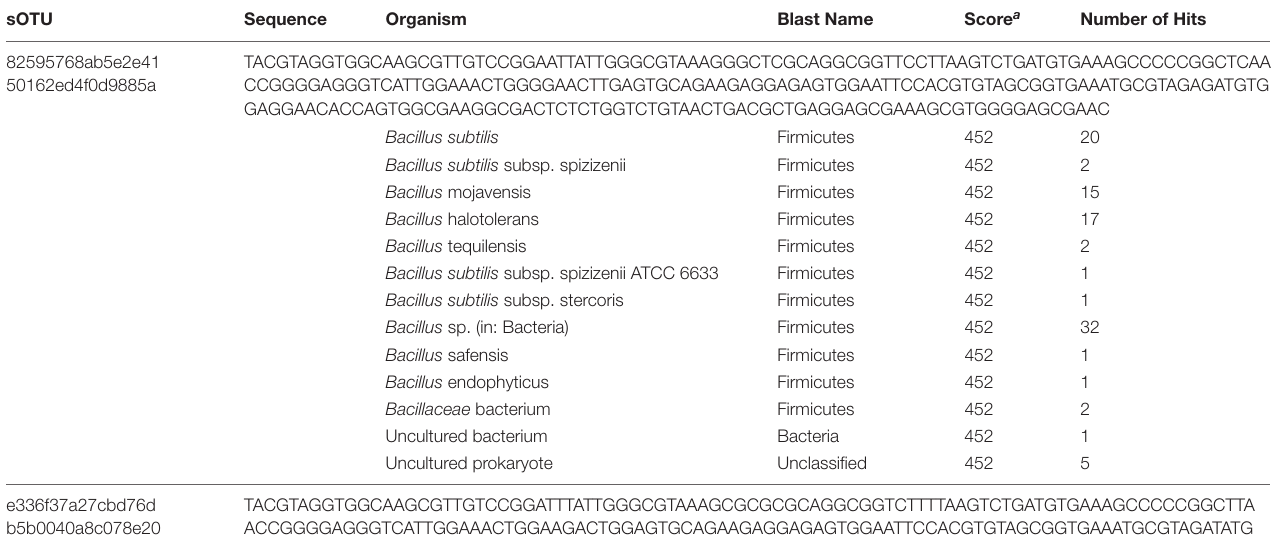
TABLE 2 | sOTUs occurring in every sample and organisms with identical sequences in the NCBI database. sOTU